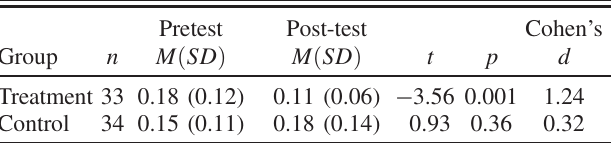
TABLE V. Results of the paired-sample t tests for confidence judgments of integrated